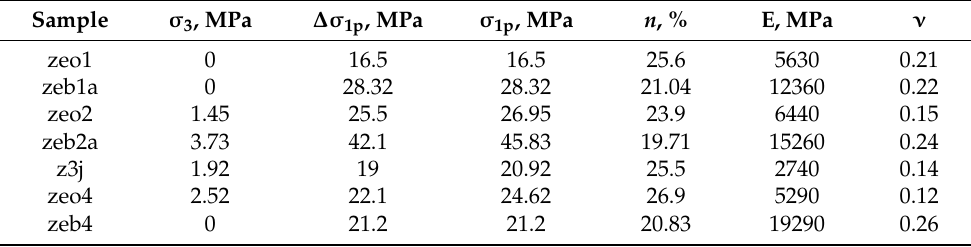
Table 6. Results of the compressive tests conducted on the zeolite-bearing